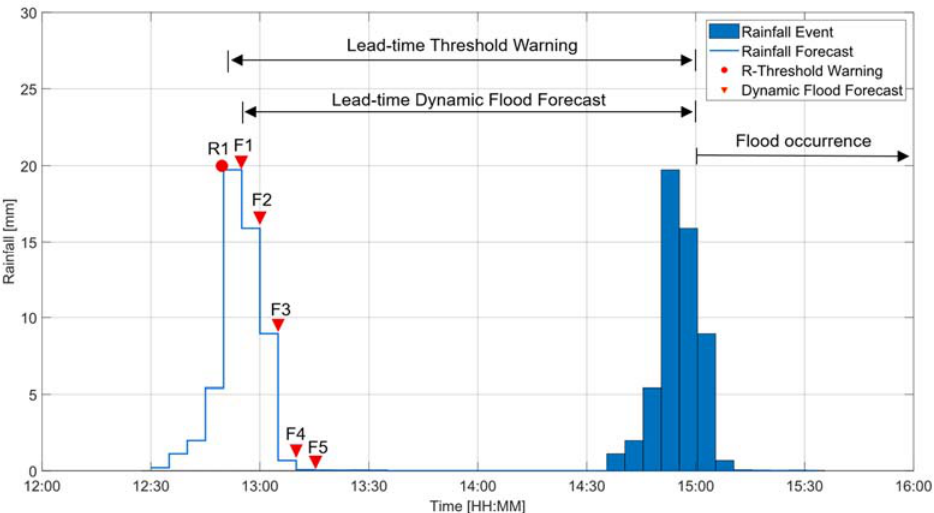
Figure 11. Test rainfall event consisting of nowcast and actual measurement of the May event (total 52 mm) and simulated warnings and forecasts of the PFA-Operator. Water 2020 , 12 , 1895